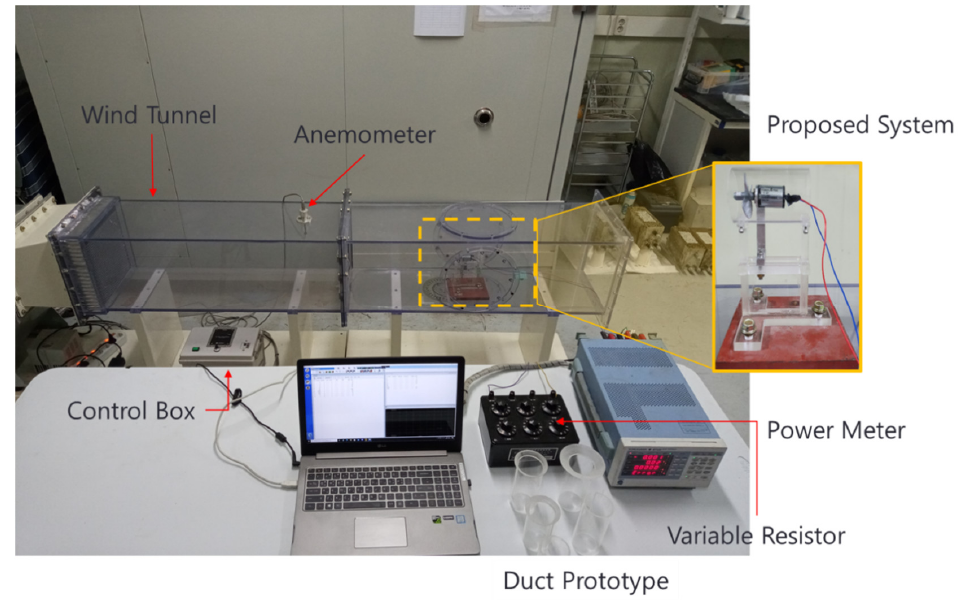
Figure 7. Experimental setup.